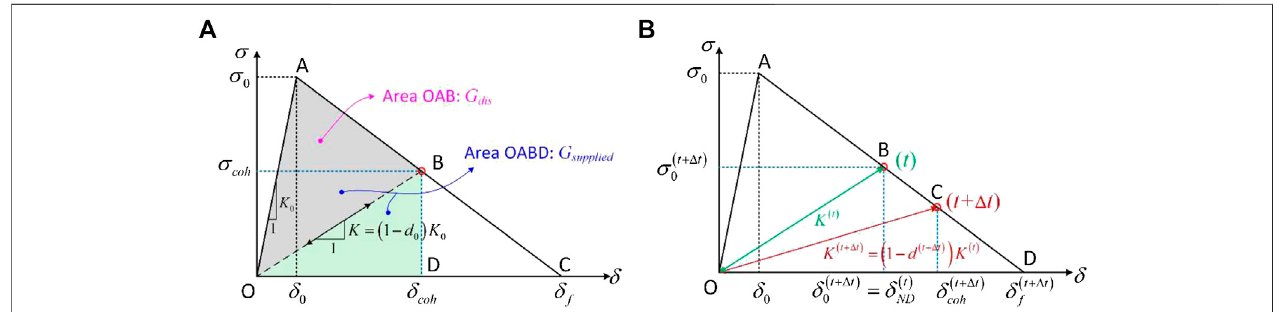
FIGURE 2 | Sketch of the bilinear cohesive law: (A) damage variable d 0 ; (B) incremental type damage variable d ( t + Δ t ) .